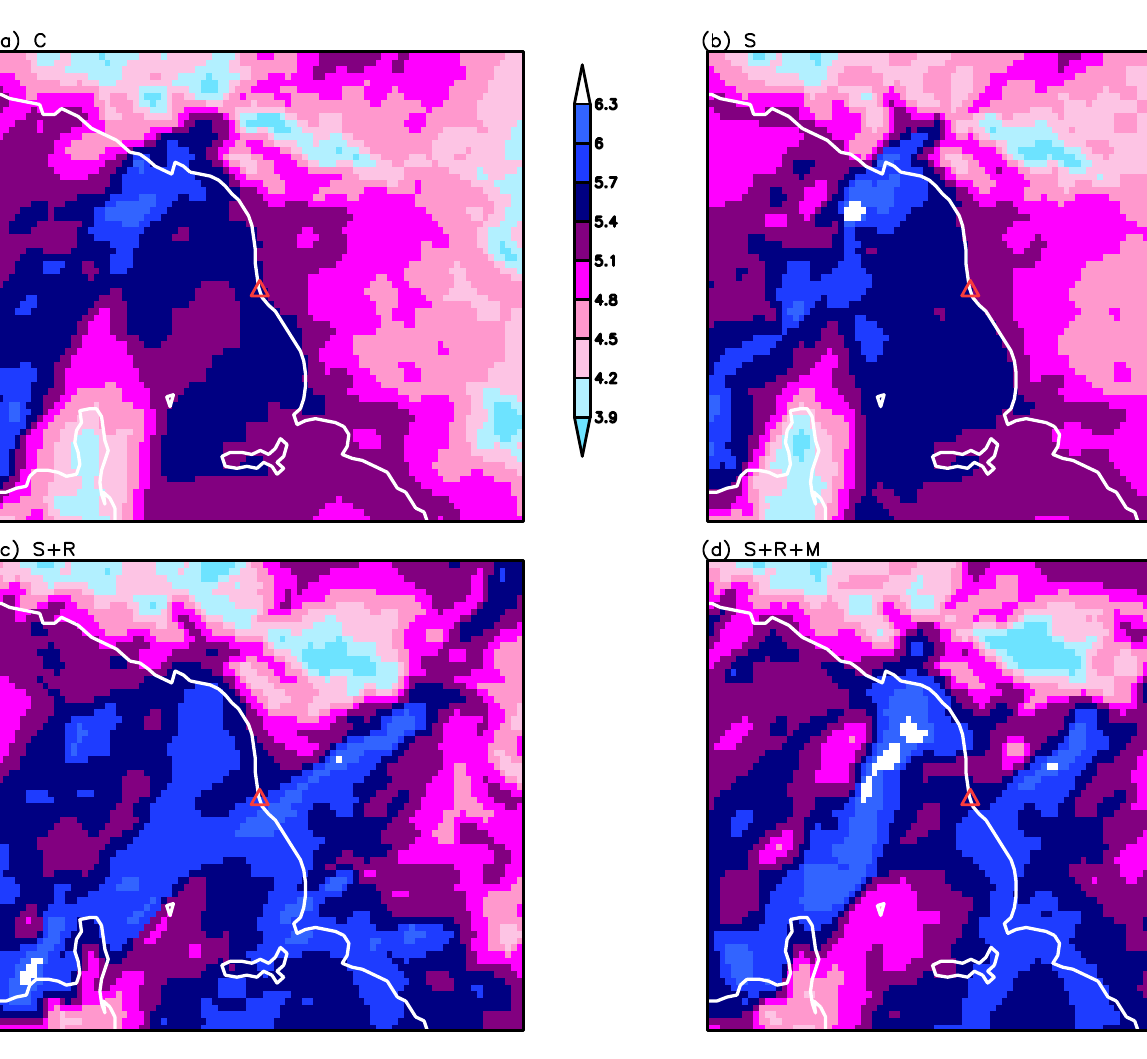
Figure 11. Mean specific humidity (unit g · kg − 1 ) over the entire vertical profile at 0000 UTC of September for ( a ) control run C , ( b ) assimilated run S , ( c ) assimilated run S + R , ( d ) assimilated run S + R + M . The red triangle (“ (cid:52) ”) indicates the Livorno